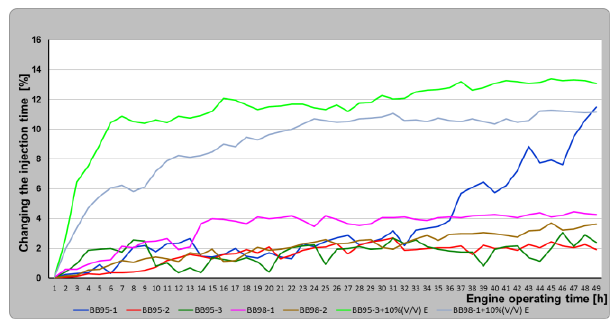
Fig. 5. Summary of fuel injection time variation results for the tested gasoline samples